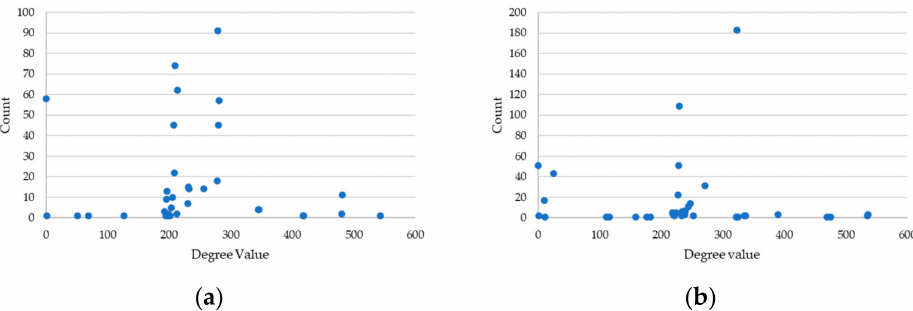
Figure 5. ( a ) The in-degree of geospatial service web; ( b ) the out-degree of geospatial service web.